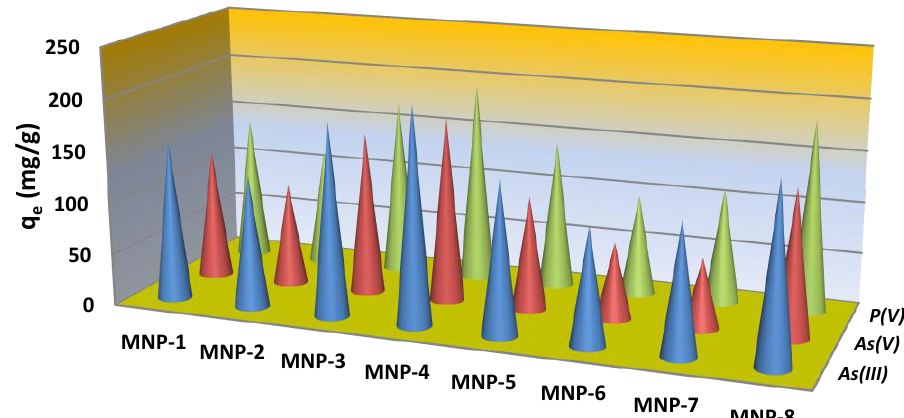
Figure 9. Adsorption performance of the obtained MNPs to phosphate, arsenate and arsenite anions (conditions: adsorbent dose, 20 mg/L; pH 6.7 ± 0.2; initial concentration of all anions, 150 mg/L; ambient temperature).